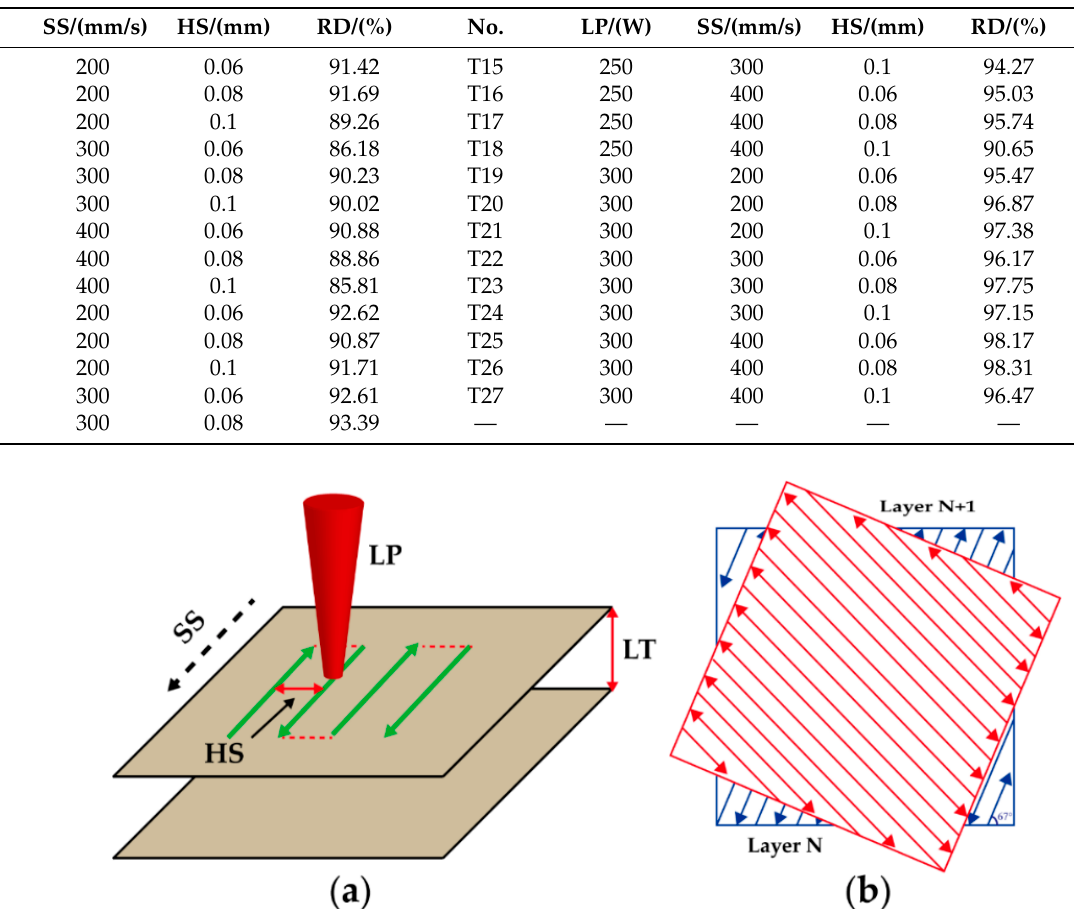
Table 1. The process parameters used in this work and measured relative density.